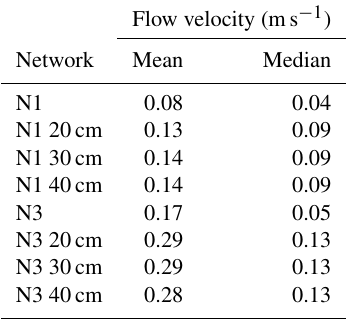
Table B1. Mean and median flow velocities, Networks N1 and N3, determined for the last 24h of a 168h simulation, using a 1h hy- draulic time